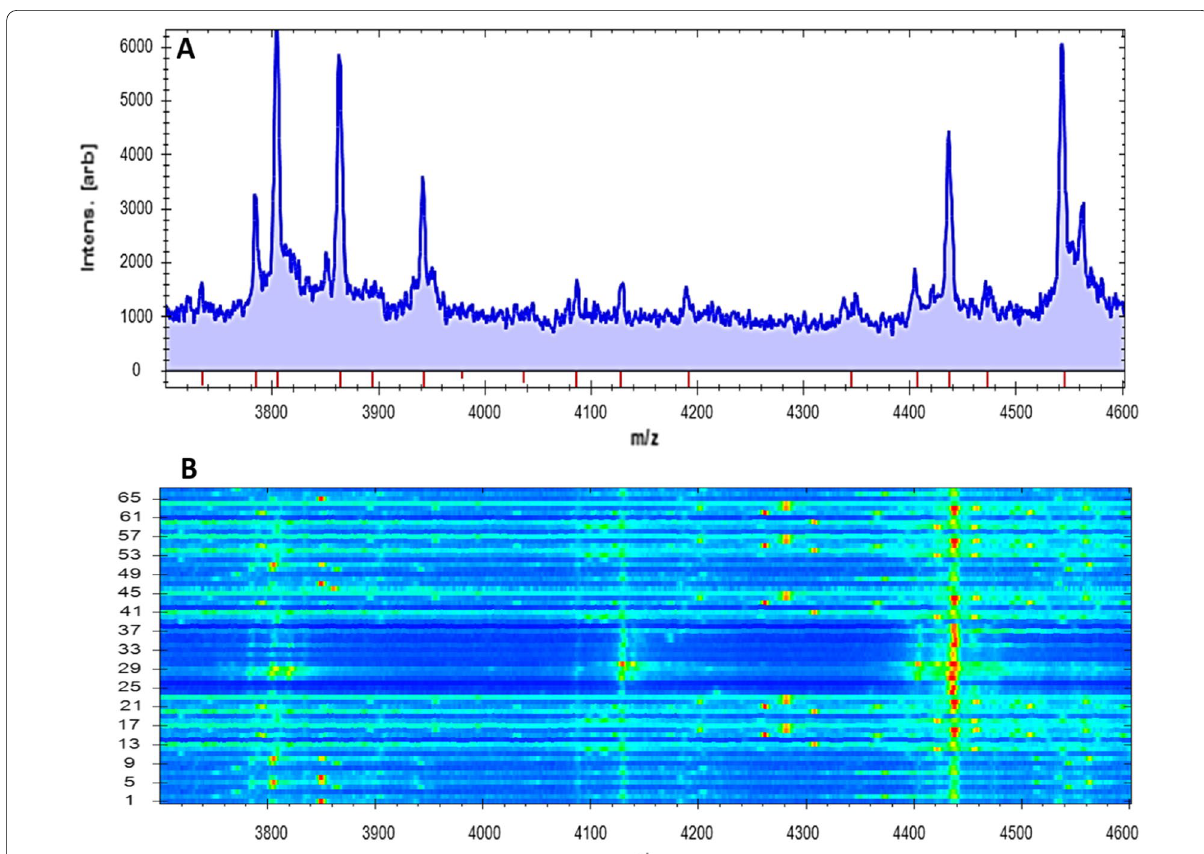
Fig. 2 Scattering of spectral proteins of 69 Pseudomonas spp. a Higher peak intensities were distributed inside the line spectra with mass charge ratios from 3000 to 4600 Da; b A gel outline of spectral proteins scattered with the same